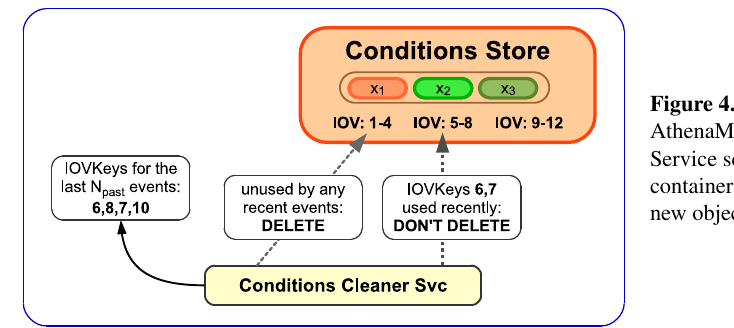
Figure 4. Garbage Collection in AthenaMT. Conditions